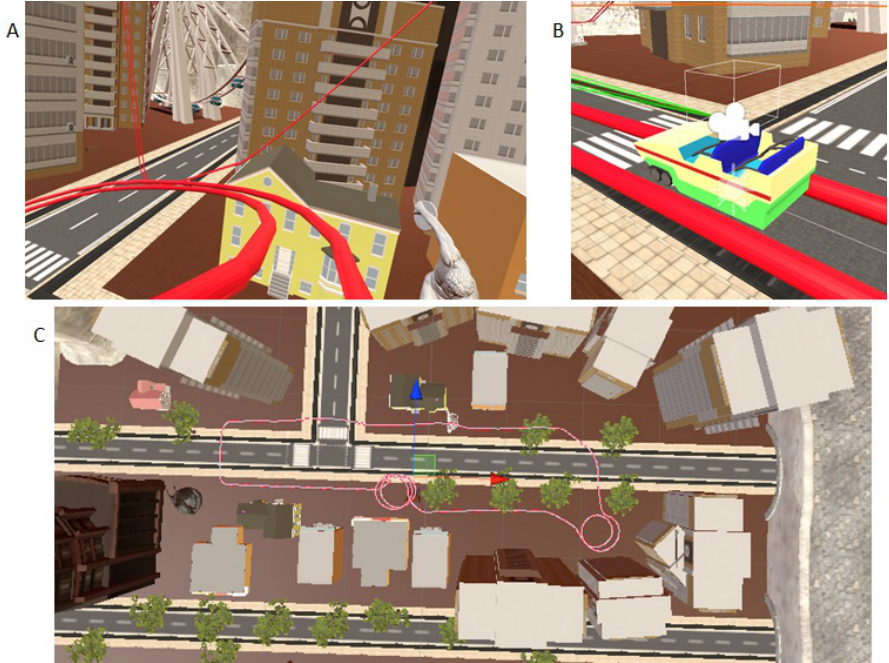
Figure 10. Rollercoaster virtual environment. ( A ) user-view; ( B ) rollercoaster cart with VR camera attached; ( C ) top view of the clustered